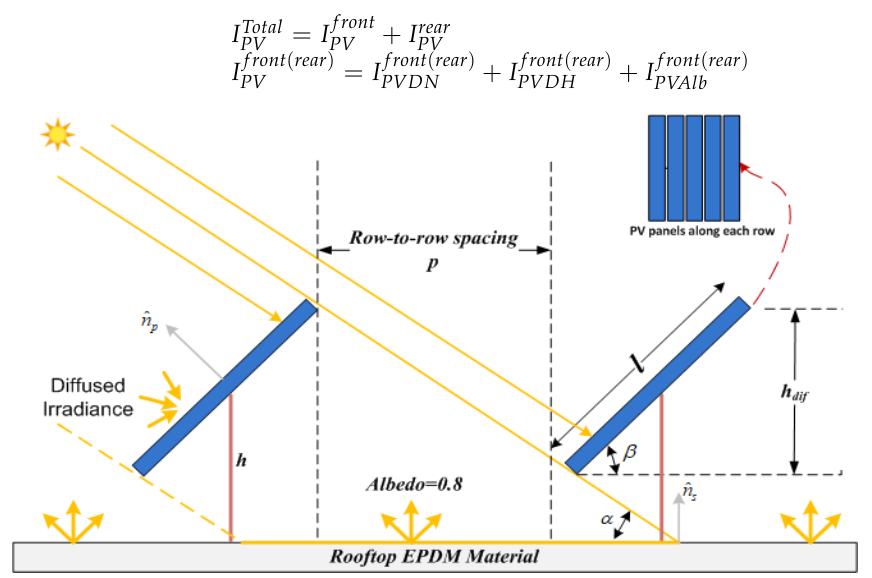
Figure 9. Illustration of irradiance on the titled solar panel. The albedo further has two components, a reflected direct beam and reflected diffused irradiance, as given in Equation (3).